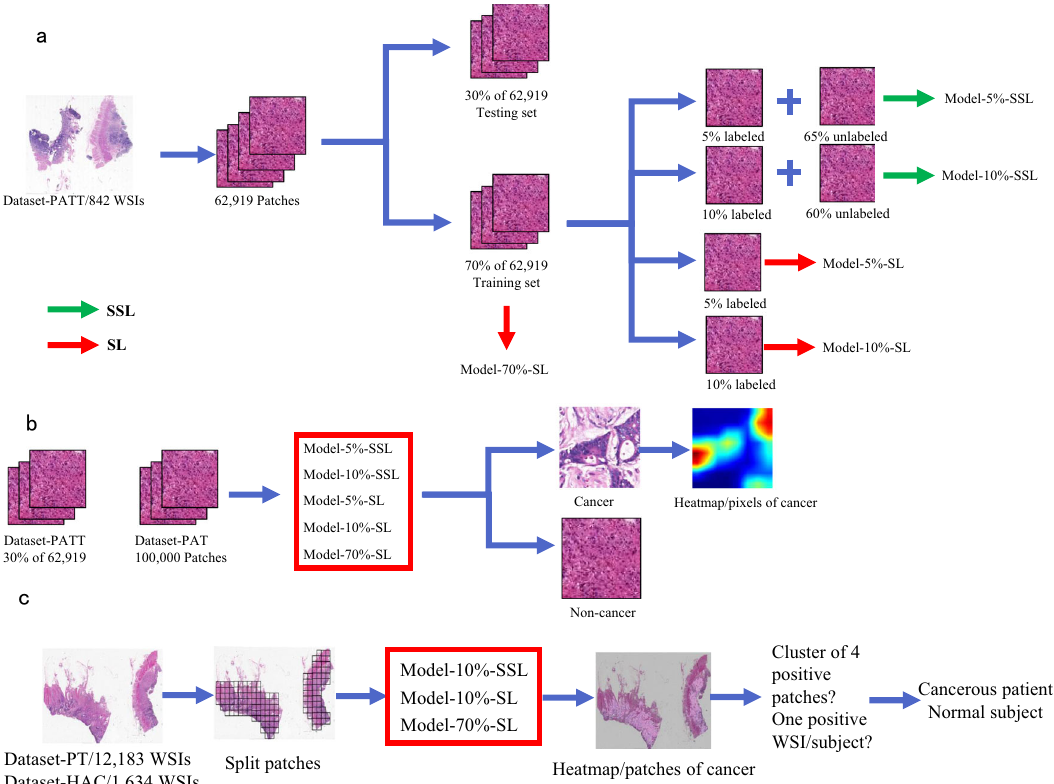
Fig. 1 The fl ow chart of the colorectal cancer study. a Semi-supervised learning (SSL) and supervised learning (SL) are performed on different labeled and unlabeled patches from 70% whole slide images (WSIs) of Dataset-PATT. Model-5%/10%-SSL and Model-5%/10%/70%-SL are obtained. b The patch- level test is performed on the patches from 30% WSIs of Dataset-PATT and whole data set of Dataset-PAT, and the above fi ve models predict whether there is cancer or not in the patches. c The patient-level test and human-AI competition are performed on Dataset-PT and Dataset-HAC, respectively. Each WSI is divided into many patches, and three models infer whether these patches are cancerous or normal individually. The clustering-based method is then used on the WSI. If there is a cluster of four positive patches on a WSI, the WSI is positive. A subject with one or more positive WSIs is cancerous, or the subject is normal. Table 2 Training and testing set for CRC patch-level models.